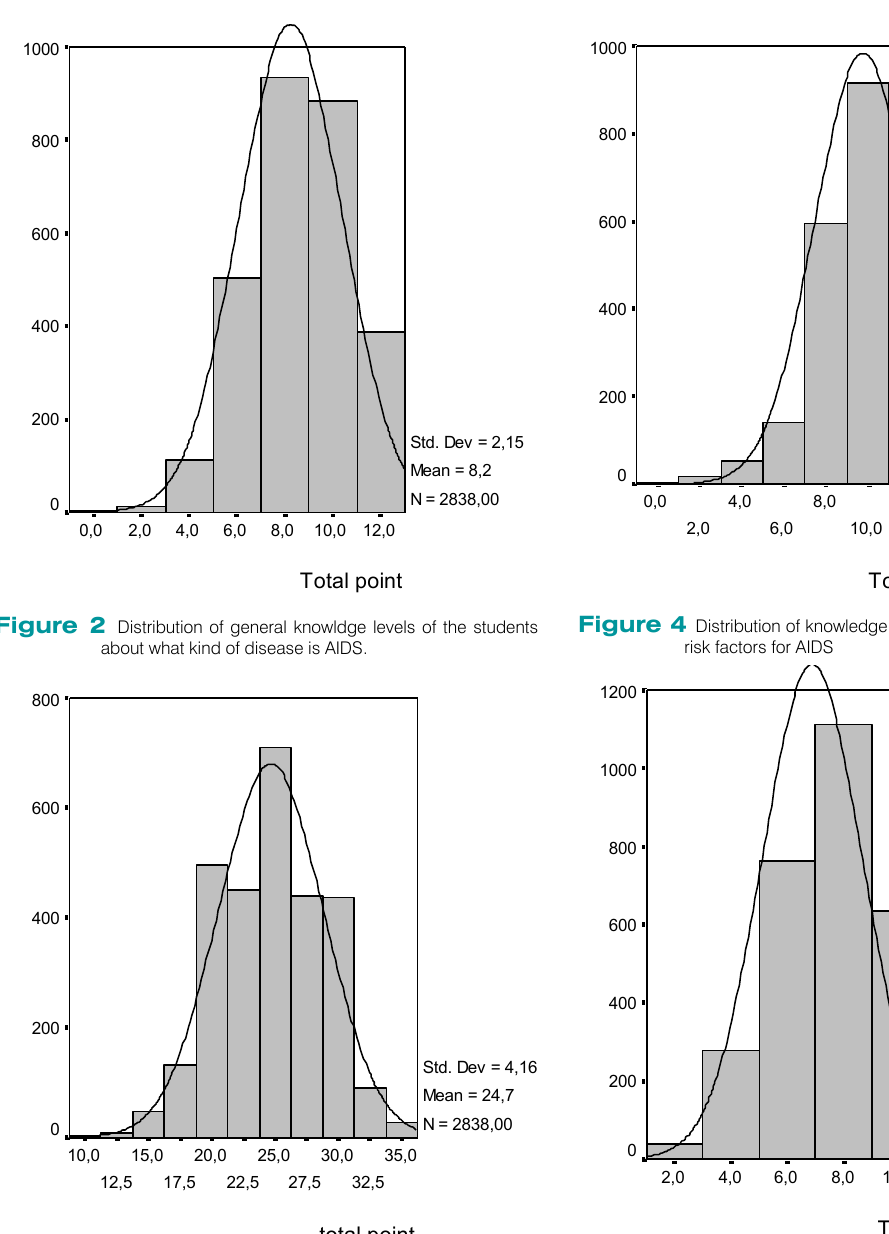
Figure 3 Distribution of knowledge levels of the students about the transmitting ways of AIDS.